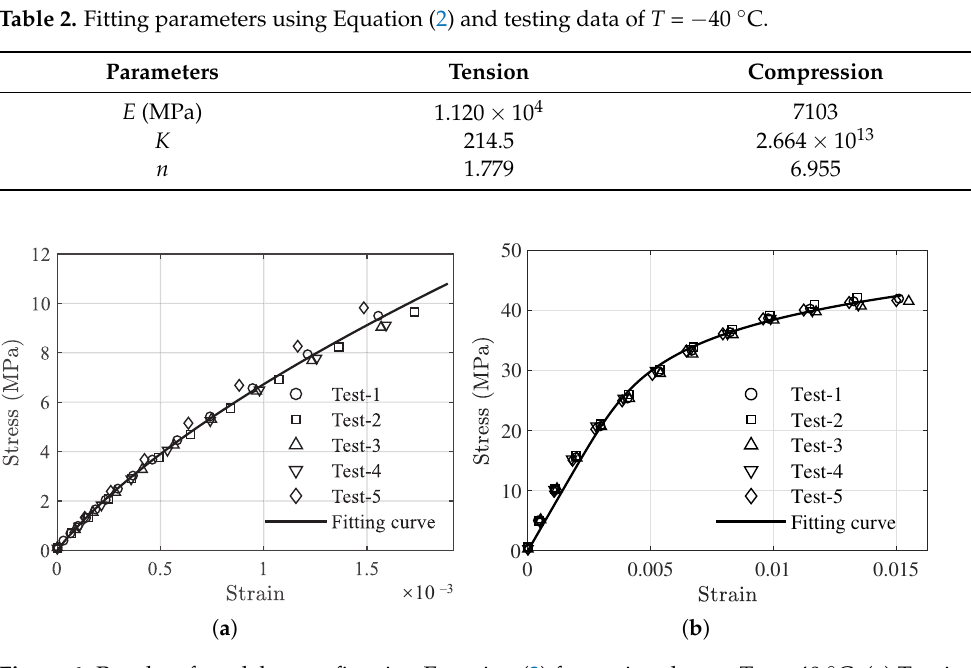
Figure 6. Results of model mean fit using Equation (2) for testing data at T = − 40 ◦ C. ( a ) Tension, and ( b )